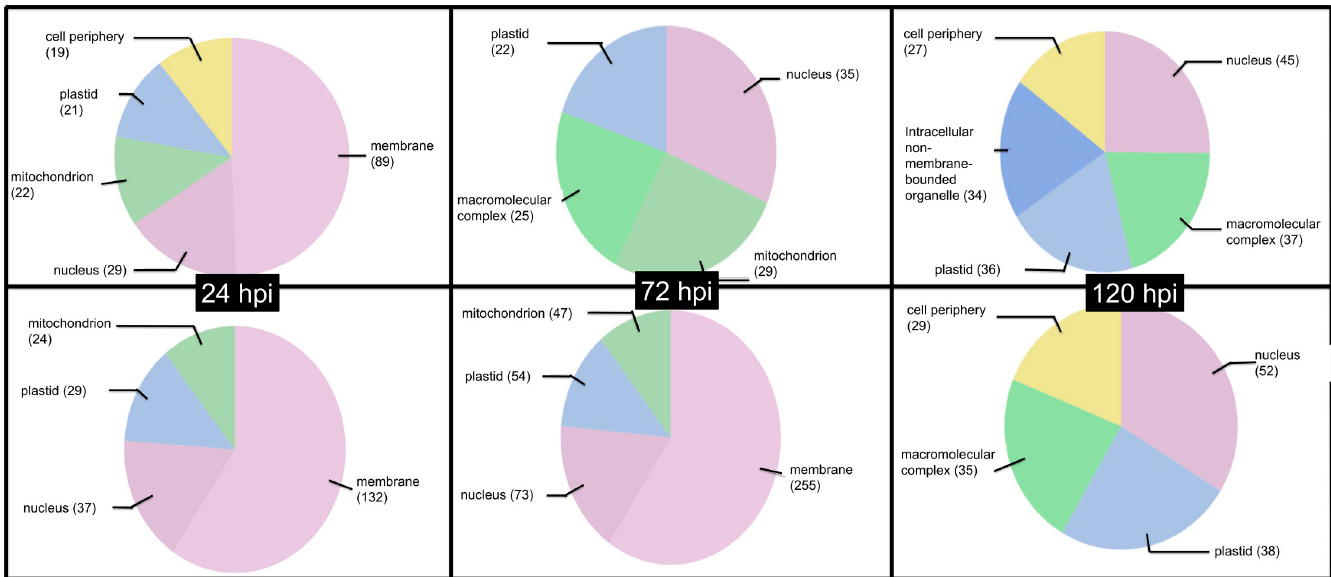
Fig 5. GO distribution for cellular component of DEG in oil palm clones during interaction process with P . palmivora . Top panel Ortet 34 (Resistant), Bottom panel Ortet 57 susceptible.